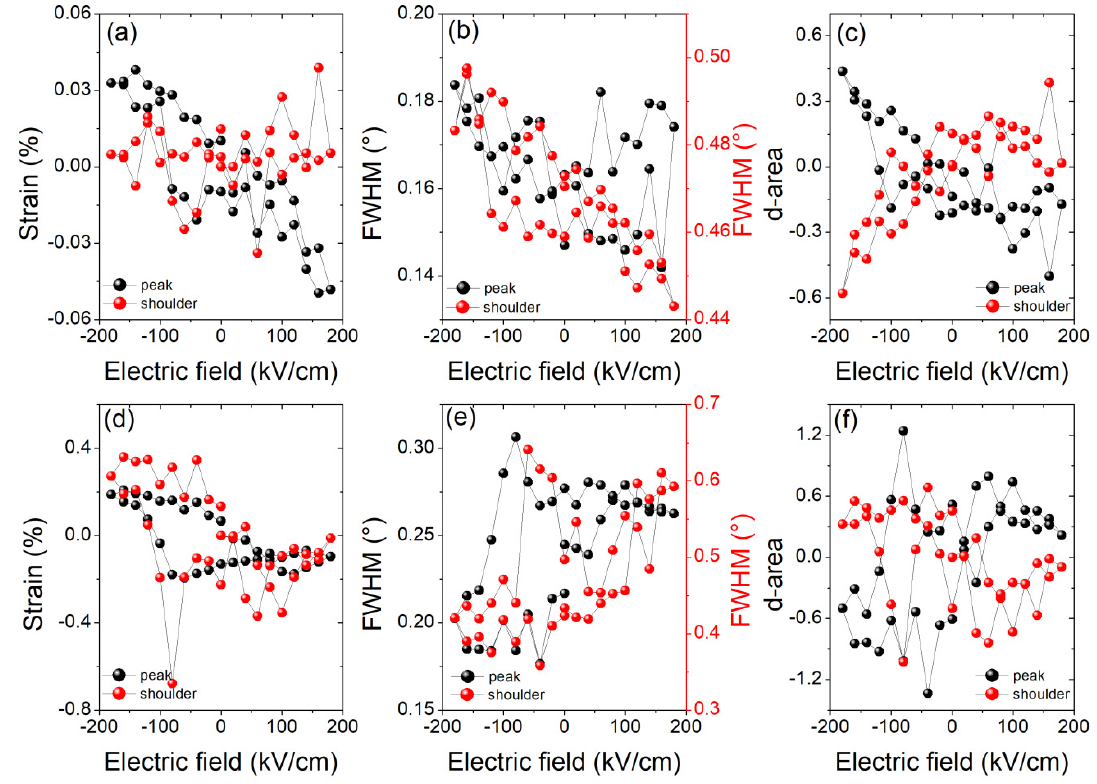
Figure 5. ( a ) Piezoelectrically-induced strain, ( b ) full width at half maximum (FWHM), and ( c ) variation of the area below the two pseudo-Voigt functions, used for fitting the profiles of the Bragg peaks shown in Figure 1a for the PLZT0 thin film (with respect to E = 0 kV/cm). ( d ) Piezoelectrically-induced strain, ( e ) full width at half maximum, and ( f ) variation of the area below the two pseudo-Voigt functions used for fitting the profiles of the Bragg peaks shown in Figure 1b for the PLZT3 thin film (with respect to E = 0 kV/cm).